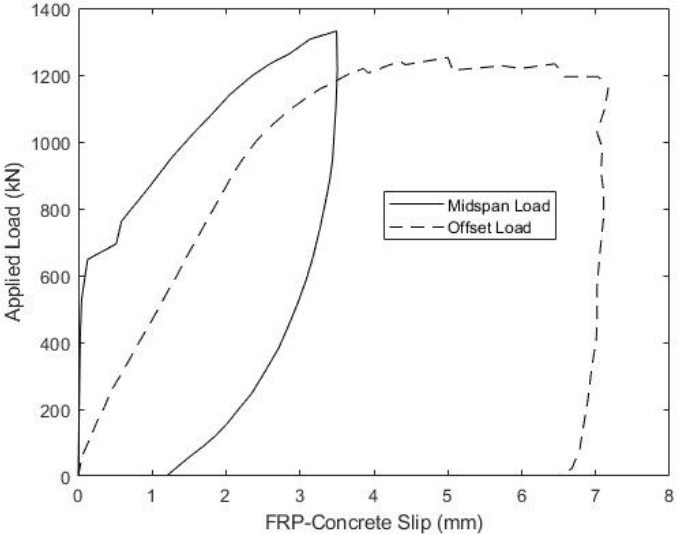
Figure 17. Beam B2 Ultimate Load-Slip Response.